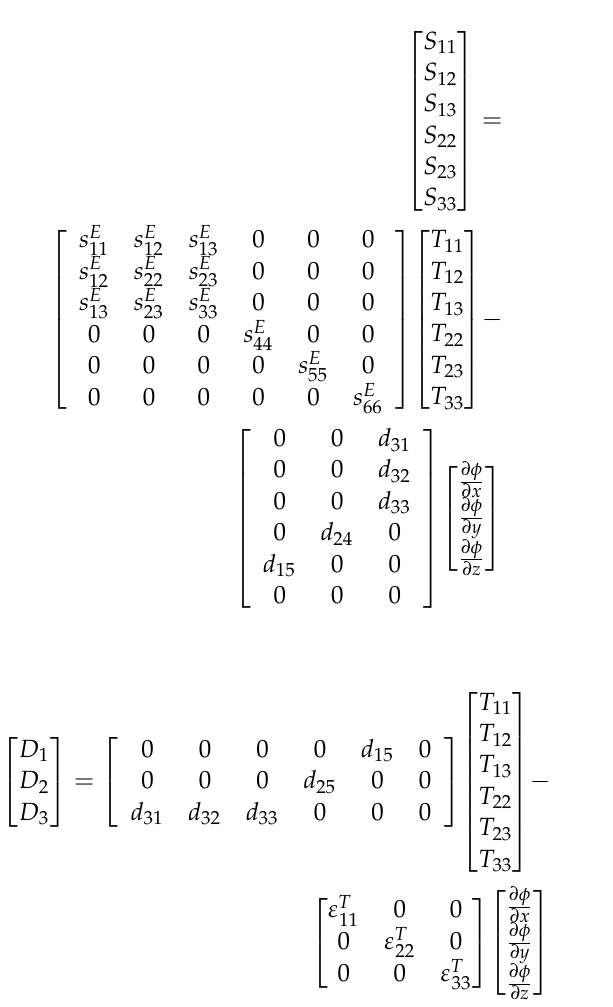
Table 7. Conservation of momentum for bulk acoustic wave in electrical part [6]. Zone Equation momentum conservation periodic left and right walls u destination = u source e ( − i k ( r destination − r top and bottom free surfaces T . n = 0, (27) The electrical boundary condition for the piezoelectric wave is depicted in Figure